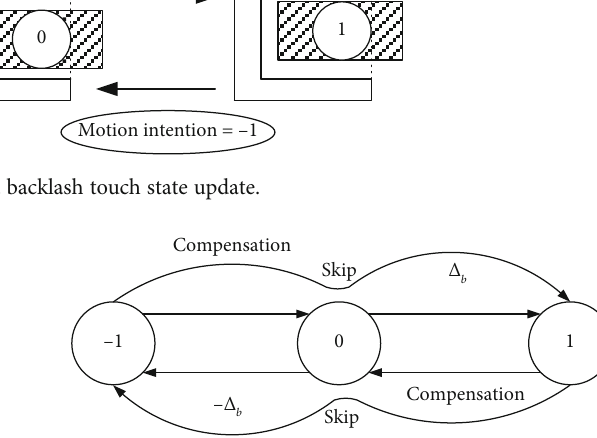
Figure 10: Schematic of touch state switch accelerate.